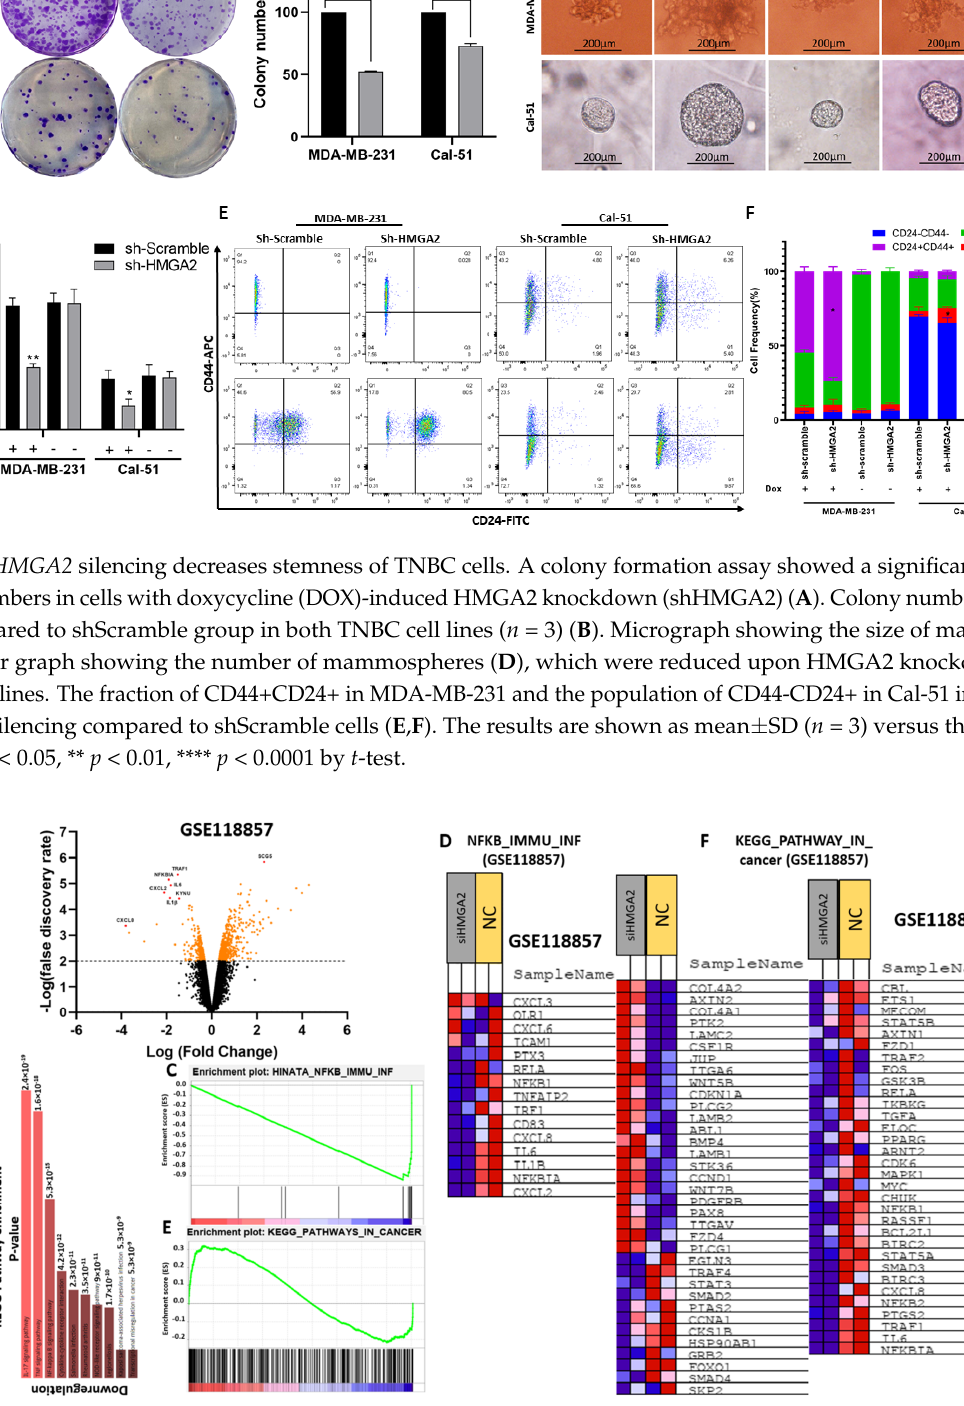
Figure 6. HMGA2 expression correlates with NF-kB signaling in TNBC. Comparative expression profiling of MDA-MB-231 cells treated with HMGA2-specific siRNA or scramble was analyzed using data from GSE 118857. A volcano plot of differentially expressed (DE) mRNAs, adjusted for fold-change>2 and p < 0.01, between HMGA2 siRNA treated and neg- ative control (Mock) treated cells ( A ). Gene enrichment showed significant alteration of the NF-kB signaling pathway upon HMGA2 silencing ( p = 8.9 × 10 −8 ) ( B ). Gene set enrichment analysis (GSEA) showed that NF-kB ( C , D ) and Cancer pathway ( E , F ) gene sets were specifically enriched among the genes differentially expressed between the HMGA2-silenced and scramble groups.